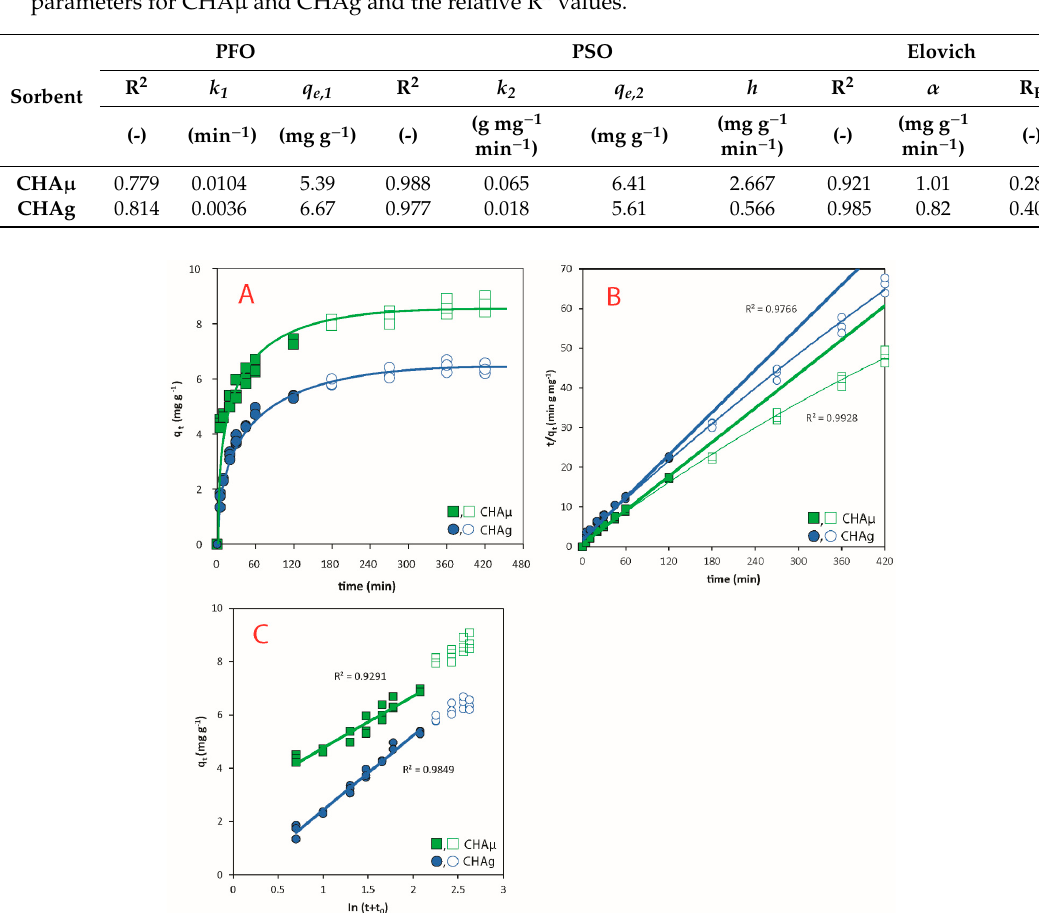
Figure 3. Kinetic graphics; full dots are data with F(t ) < 85%, thus they have been considered in kinetic analyzes; empty dots are data with F(t ) > 85%, thus they were not taken into consideration: ( A ) q t against t plot for CHA μ and CHAg; the curve indicates the general trend with respect to time; ( B ) PSO plot ( t / q t against t ) thinner lines are representing the trend of all data; straight regression lines are the PSO linear equations (Equation (10)); ( C ) Elovich plot (ln( t + t 0 ) versus q t ); straight lines represent the Elovich linear equation (Equation (14)). Diffusion dynamics of NH 4+ has shown different behaviours when comparing CHAg and CHA μ (Figure 4); in particular, the ID plot for CHA μ has shown only a straight line with an intercept C ~ 4,